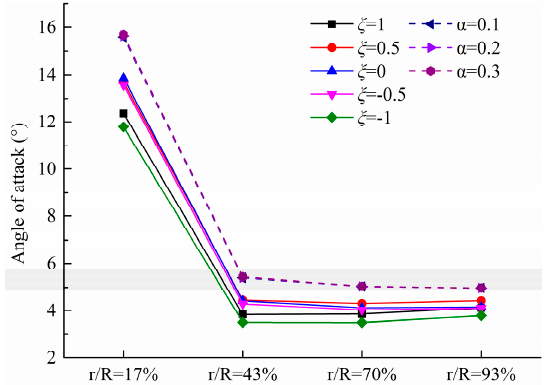
Figure 11. Angle of attack at different span-wise locations of the blade ( r / R = 17%, 43%, 70%, and 93%) under different inflow conditions.